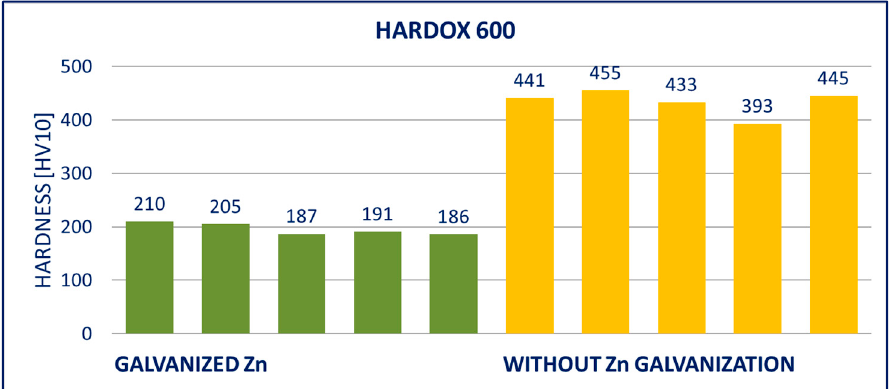
Figure 15. Results of hardness HV10 of specimens of HARDOX 600 steel.